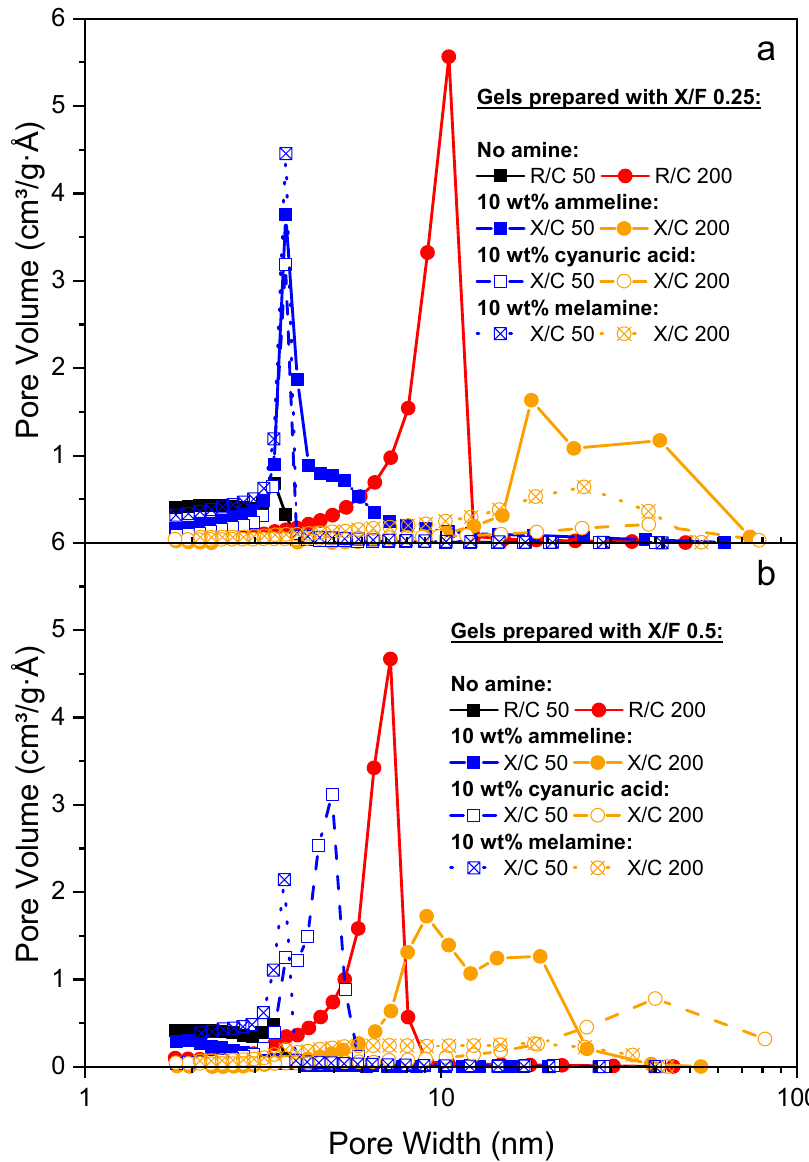
Figure 6. Pore size distributions for gels prepared with 10 wt% of additives with ( a ) X/F 0.25 and ( b ) X/F 0.5.